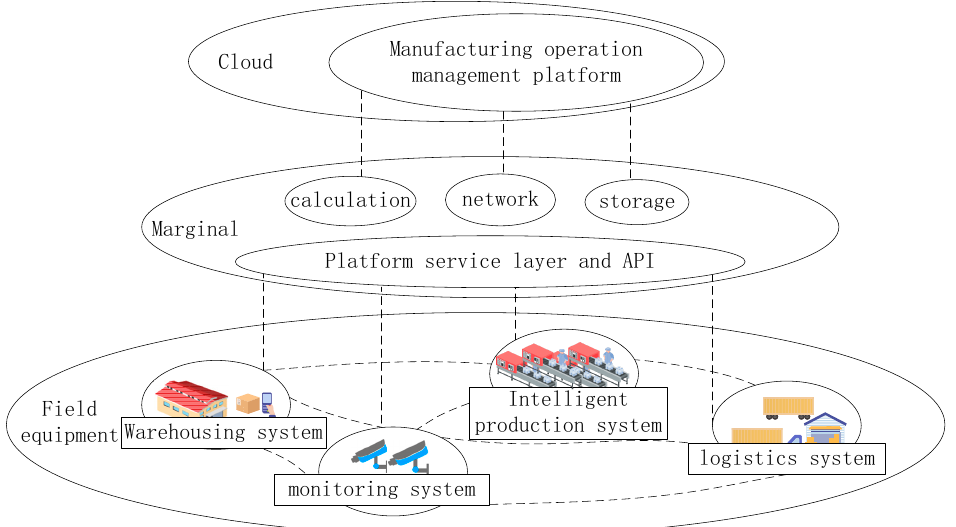
Figure 3. Edge computing architecture.